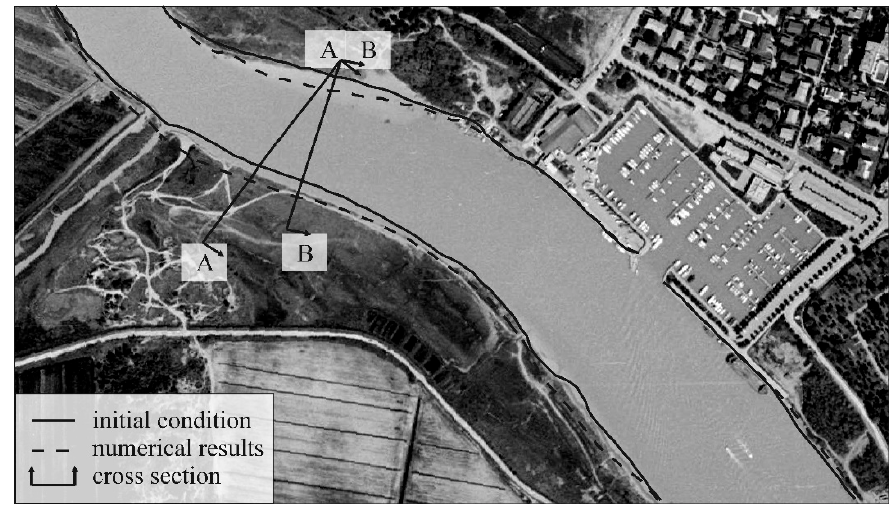
Figure 11. Meander migration in the Tagliamento River: the shoreline in the initial conditions and at the end of the five-year simulation. The background is a historical aerial image of the area (1988).